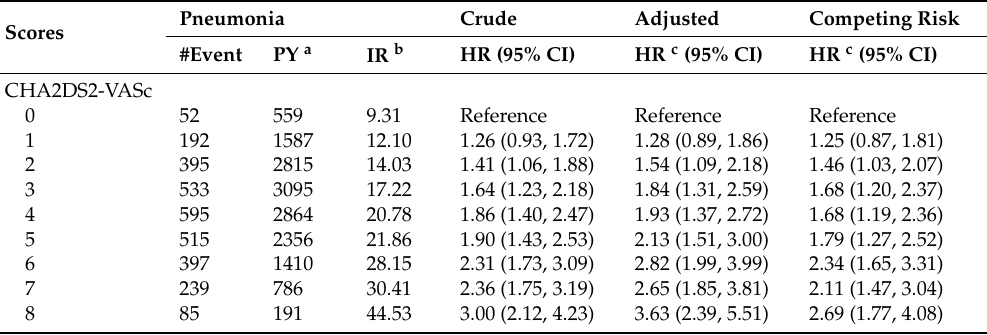
Table 3. Incidence rates and risks of pneumonia in COPD patients with